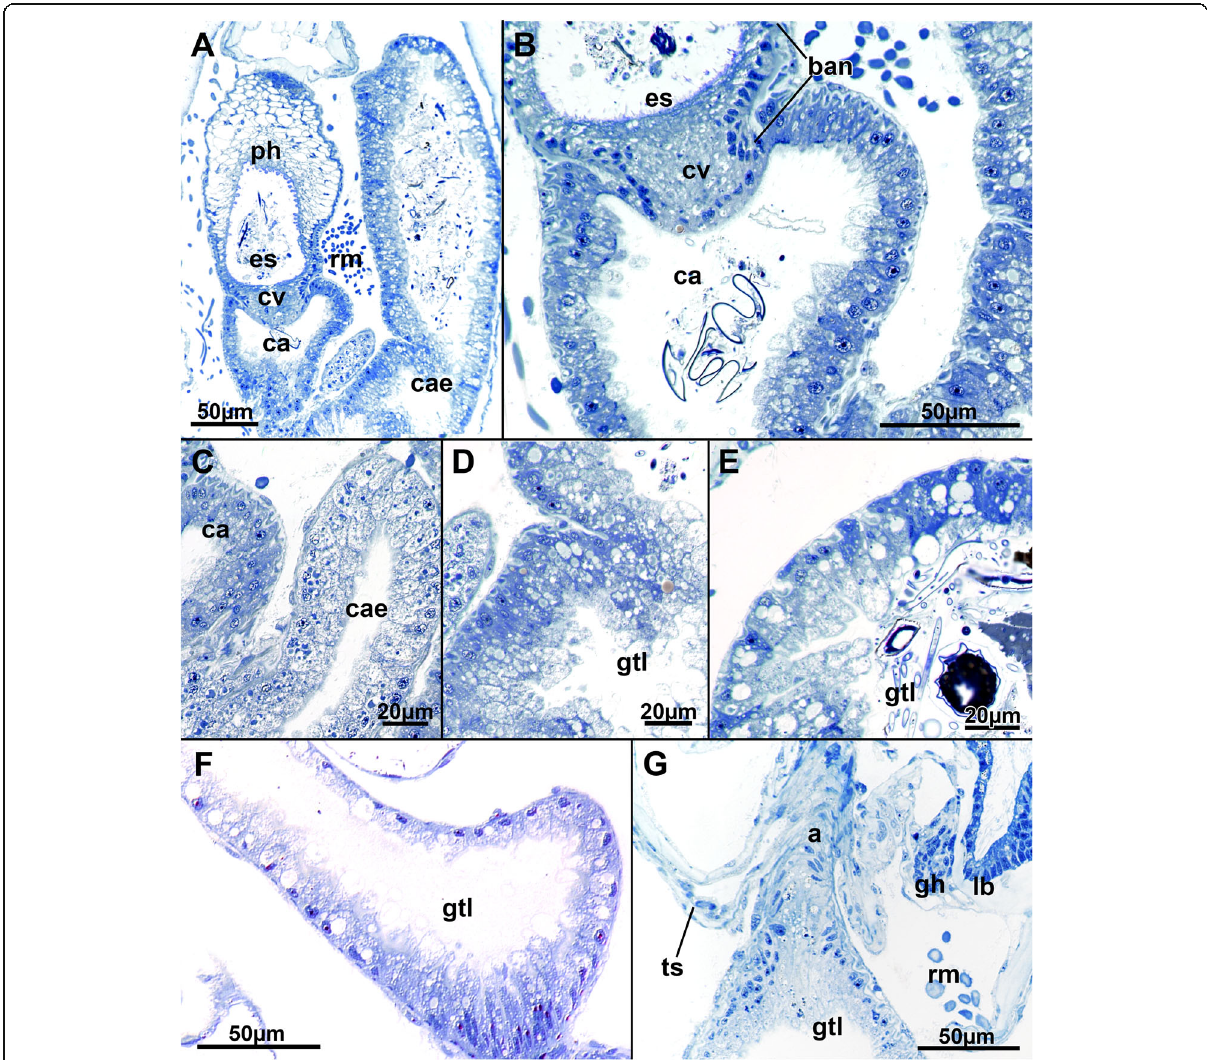
Fig. 12 Histological details of the mid- and hindgut of Stephanella hina . a Longitudinal section of a polypide showing the transition of the esophagus to the cardia and parts of the caecum. b Close-up of the cardiac valve and cells of the cardia. c – e Detailed images of the cellular architecture of the caecum epithelium showing its variable cellular architecture. f Details of the cells of the intestine. g Detail of the anal area entering the tentacle sheath. Abbreviations: a - anus, ban - basal nuclei, ca - cardia, cae - caecum, cv - cardiac valve, es - esophagus, gh - ganglion horn, gtl - gut lumen, lb. - lophophoral base, ph - pharynx, rm. - retractor muscles, ts – tentacle